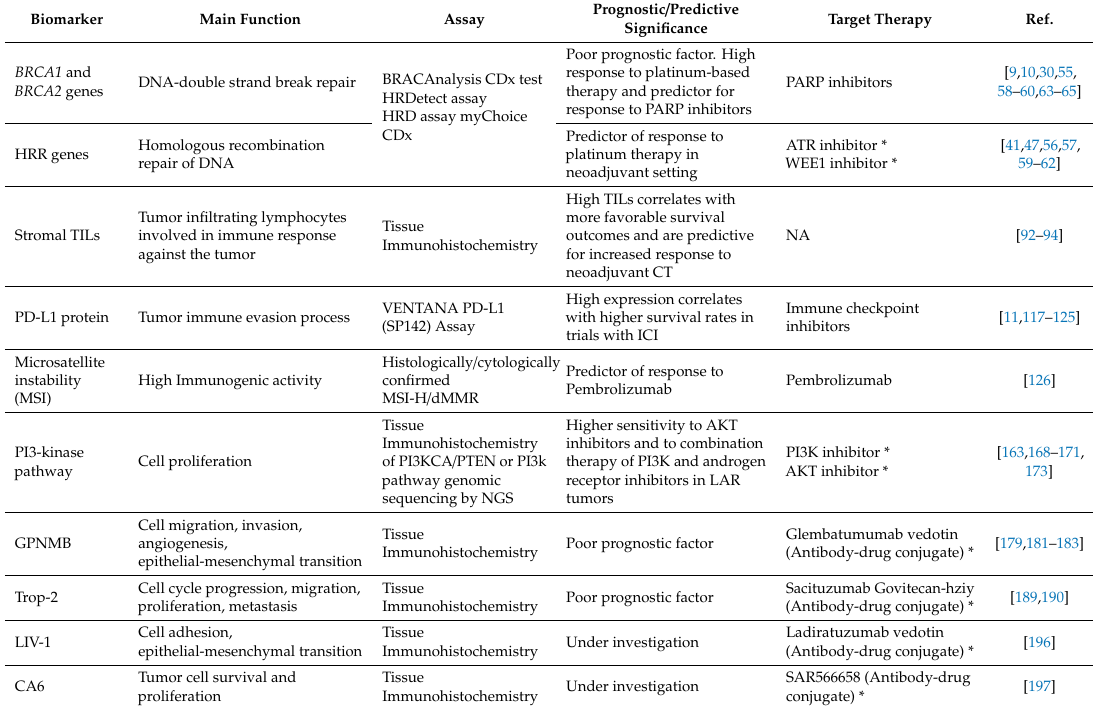
Table 1. Summary of biomarkers in triple negative breast